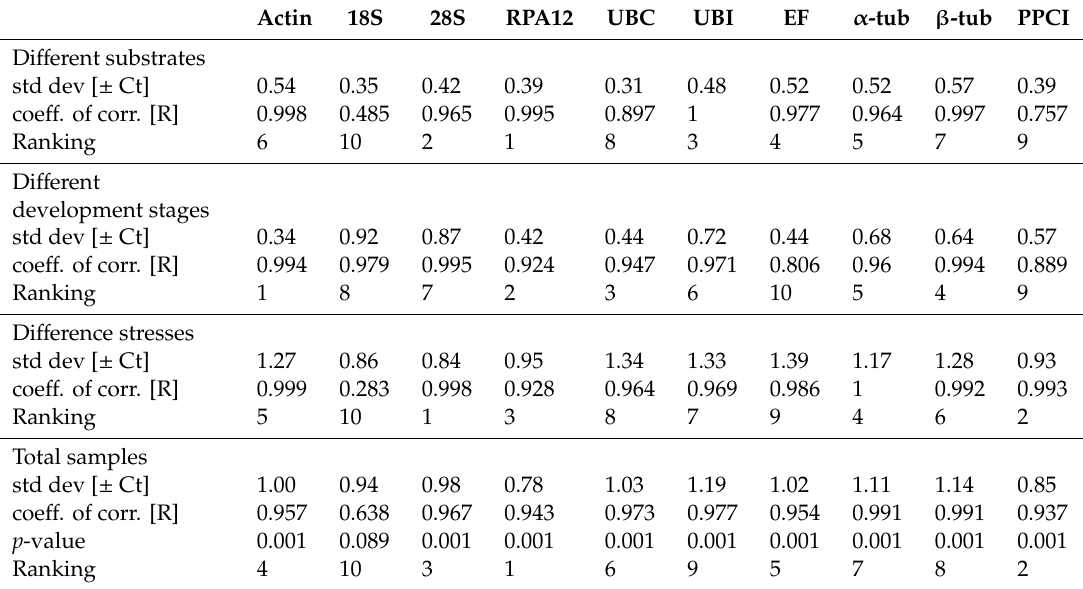
Table 3. Stability analysis of eighteen candidate reference genes by